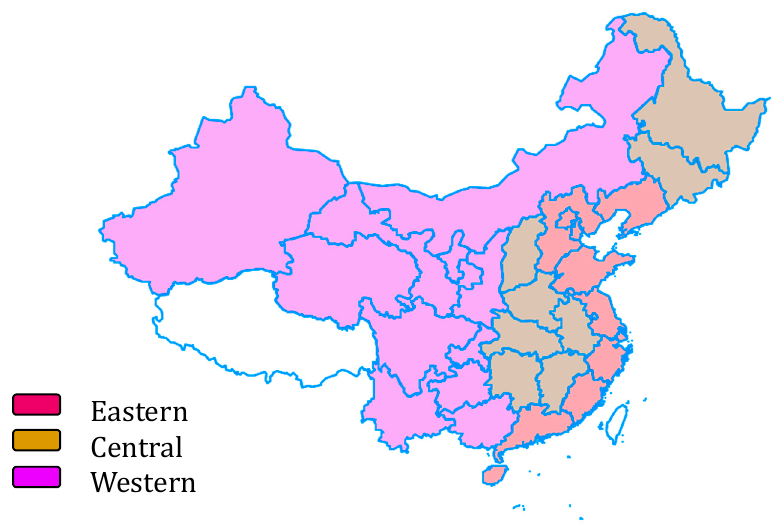
Figure 1. Regional breakdown in the study.